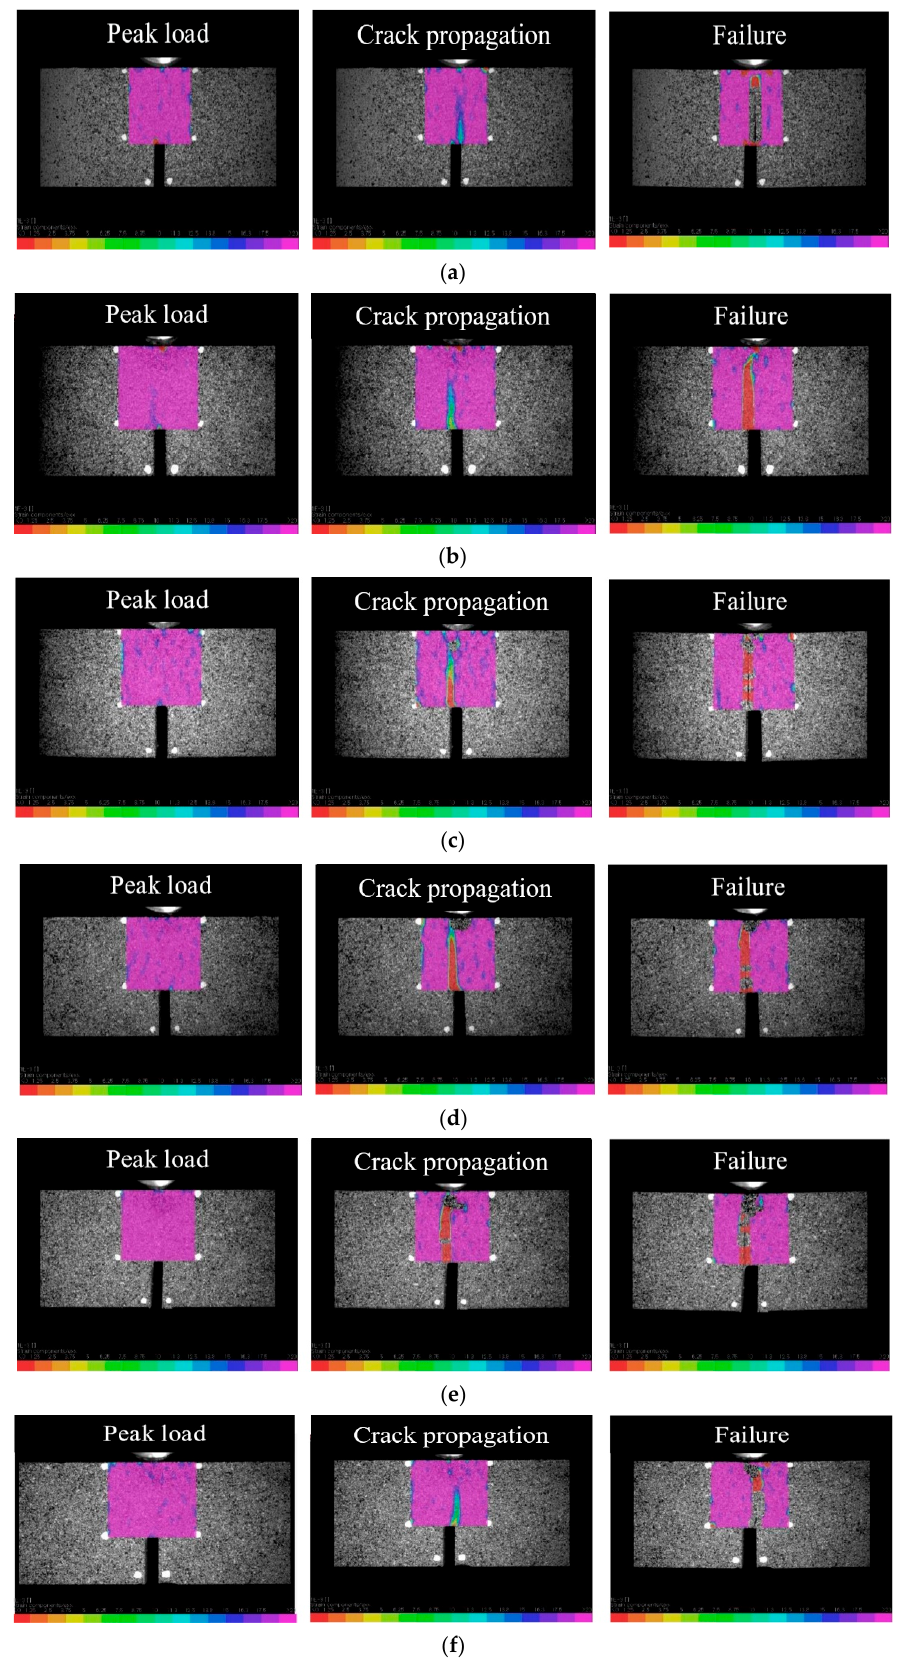
Figure 11. Transverse strain contour of IFT specimens; ( a ) F-00-0, ( b ) F-00-50, ( c ) F-00-100, ( d ) F-15-0, (e) F-15-50, ( f ) F-15-100.